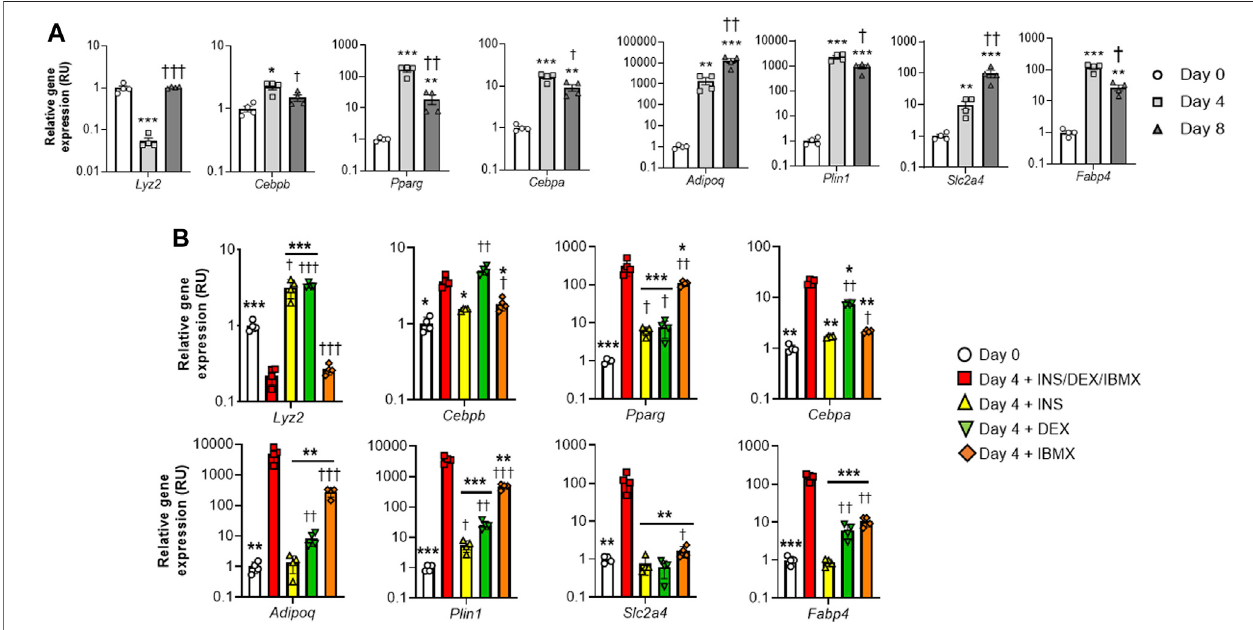
FIGURE 1 | Lyz2 gene expression during 3T3-L1 adipocyte differentiation. (A) Lyz2, Cebpb, Pparg, Cebpa, Adipoq, Plin1, Slc2a4 and Fabp4 gene expression during 3T3-L1 adipocyte differentiation. ** p < 0.01 and *** p < 0.001 compared to Day 0; † p < 0.05, †† p < 0.01 and ††† p < 0.001 compared to Day 4. (B) The effect of individual compound administration (INS, DEX or IBMX) of differentiation cocktail on Lyz2, Cebpb, Pparg, Cebpa, Adipoq, Plin1, Slc2a4 and Fabp4 gene expression during 4 days. ** p < 0.01 and *** p < 0.001 compared to complete differentiation cocktail (INS/DEX/IBMX); † p < 0.05, †† p < 0.01 and ††† p < 0.001 compared to Day